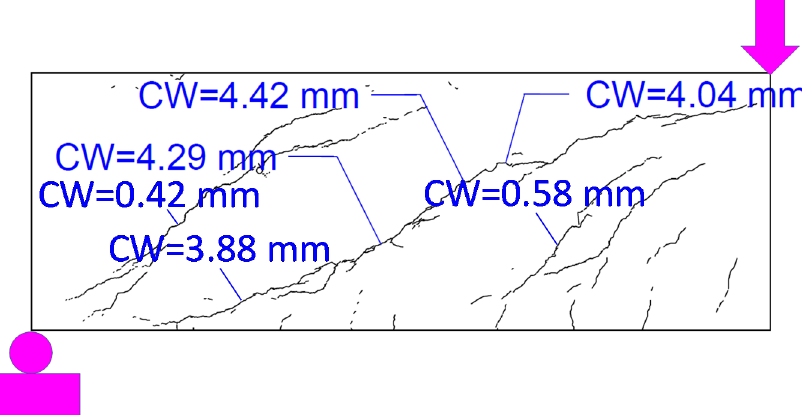
Figure 7. Crack maps and width at the peak load of 635 kN.